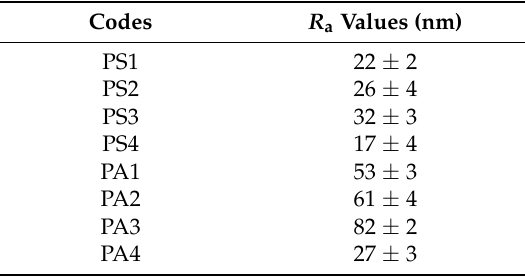
Table 4. The R a values of PS and PS/Al 2 O 3 nanocomposite